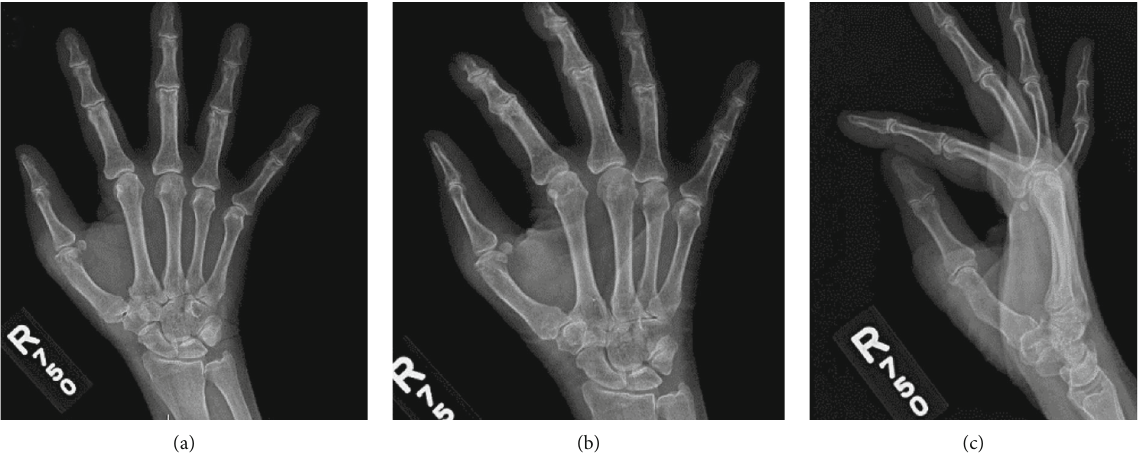
Figure 4: A 3-view X ray of the right hand taken one month postoperatively. (a) Interval resection of the extra digit, dorsal view. (b) Mild degenerative osteoarthrosis of the MCP, oblique view. (c) Mild degenerative osteoarthrosis of the IP joints, lateral view.